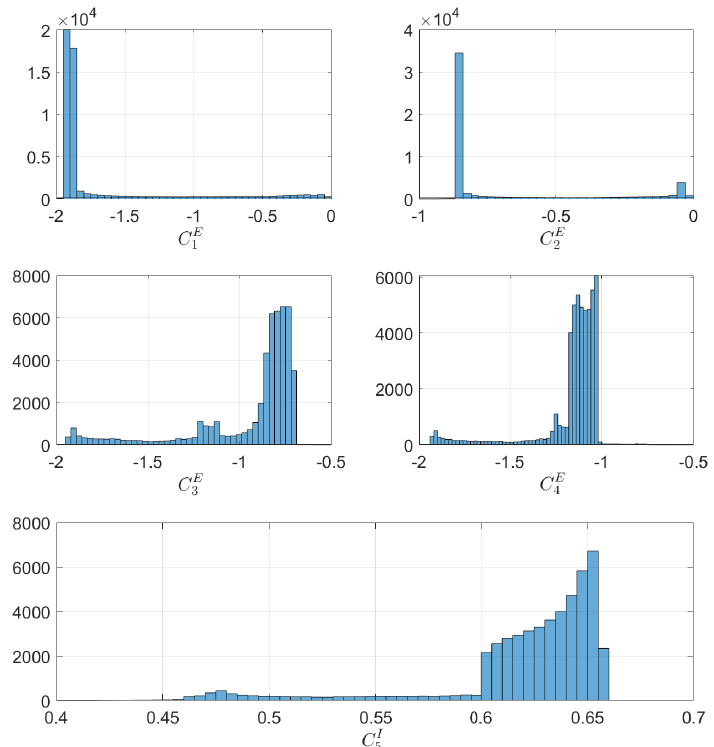
Figure 16. Histogram for the Constraint calculated in Equation (33) and Equation (34) under exclusion and inclusion